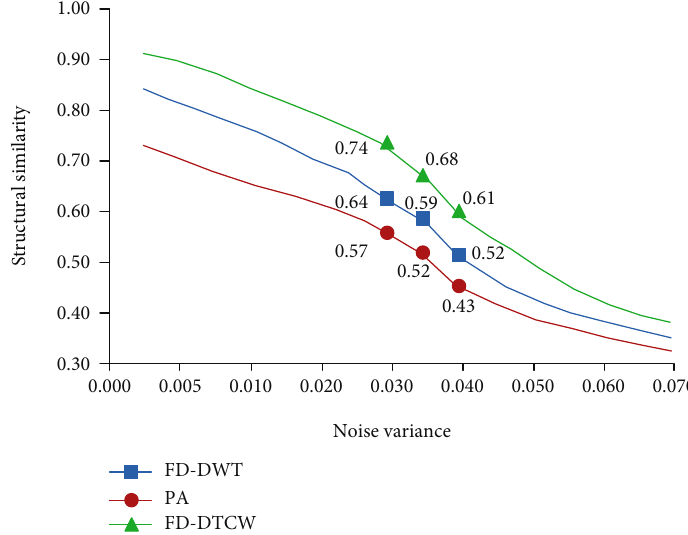
Figure 10: Changes in the structural similarity of each model on the test